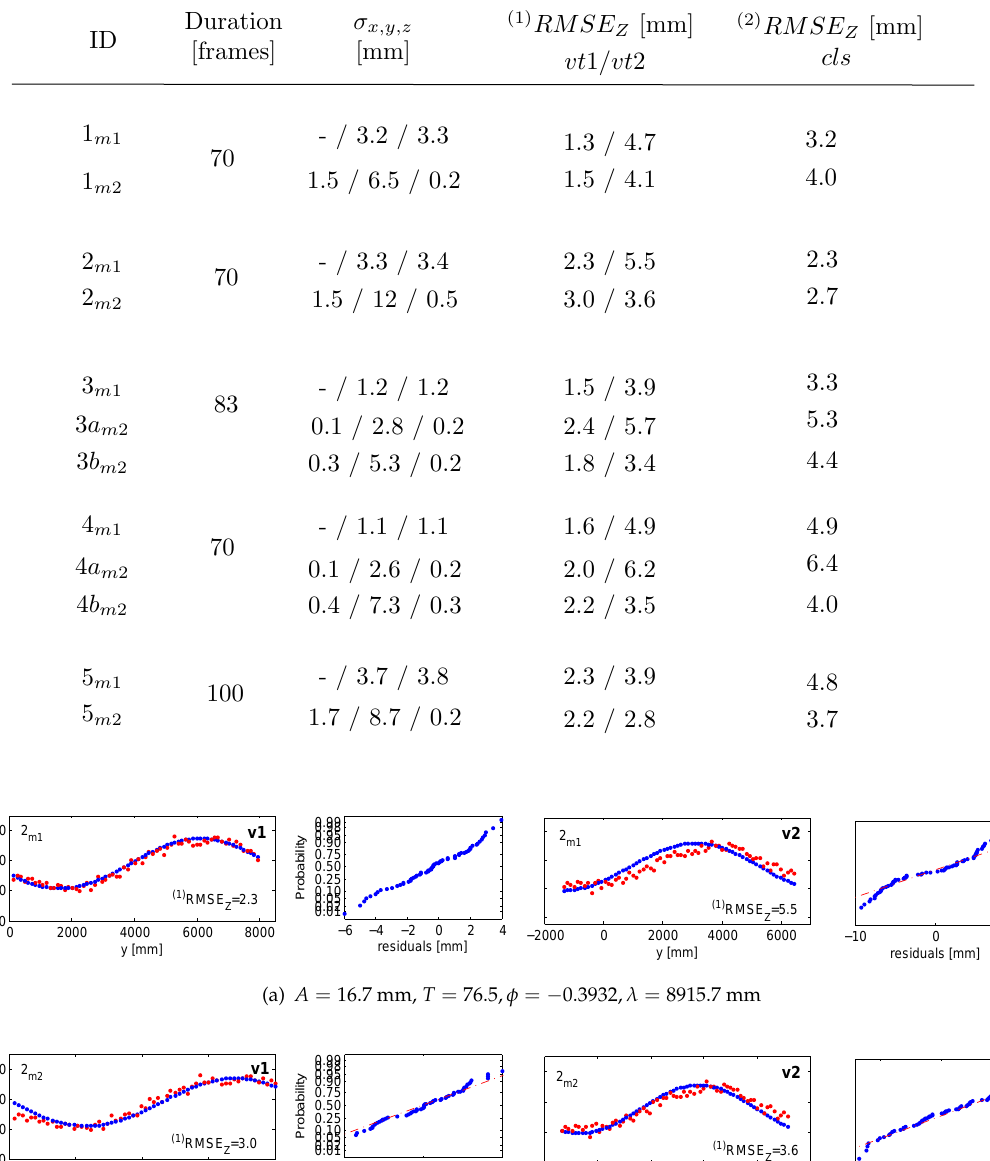
Table 1. Mean precision ( σ x , y , z ) and accuracy ( ( 1 ) RMSE z , ( 2 ) RMSE z ) of five measurement series evaluated with Method 1 and Method 2.